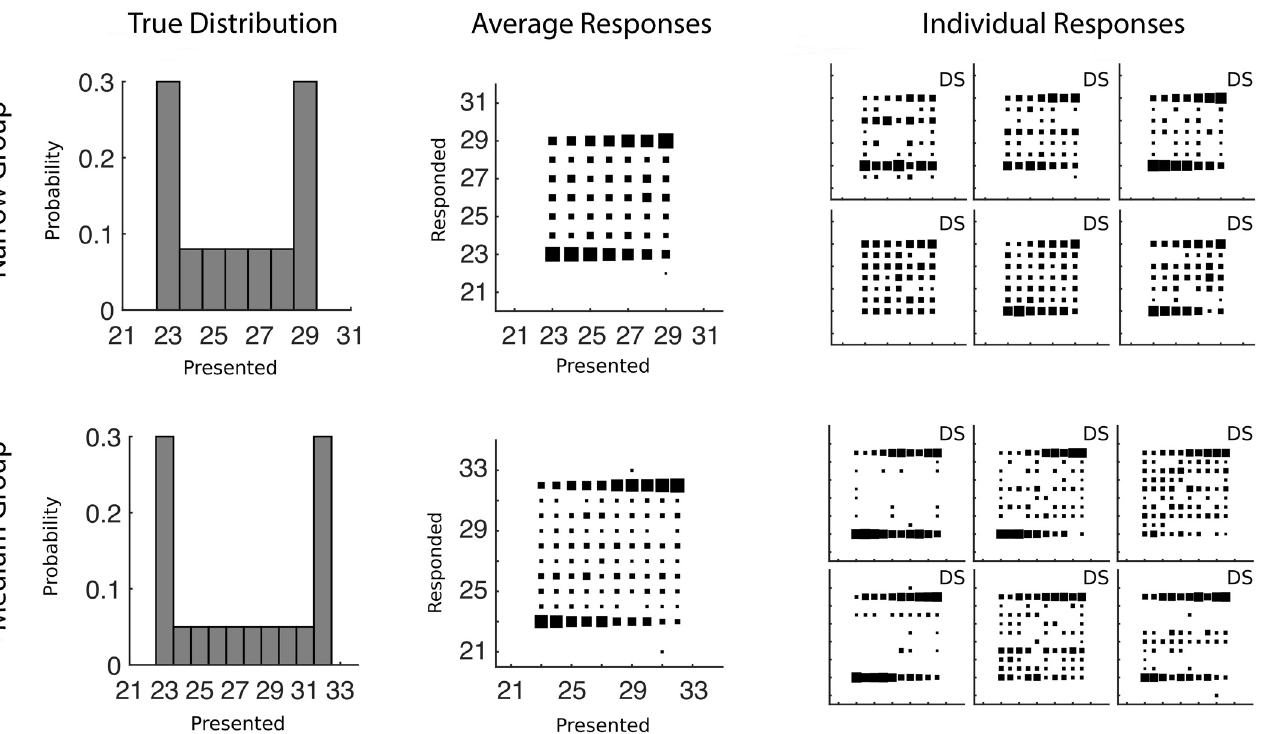
Fig 4. Training distributions and conditional response distributions for each group of participants after 300 trials in Experiment 2 (estimates of the area of a rectangle). Each group of participants is in a separate row. The left column of plots shows the probability with which each number was presented to participants. The middle column shows aggregate conditional response distributions with the area of each square representing the relative frequency of making a particular response given a particular presented stimulus. The right column shows the conditional response distributions for each participant. The letters D and G mark participants who are using a categorical (Dirichlet prior) or Gaussian kernel prior respectively and the letters A, M, and S mark the participants who were characterized as using the mean (Average), Max, or Sampling decision functions respectively.